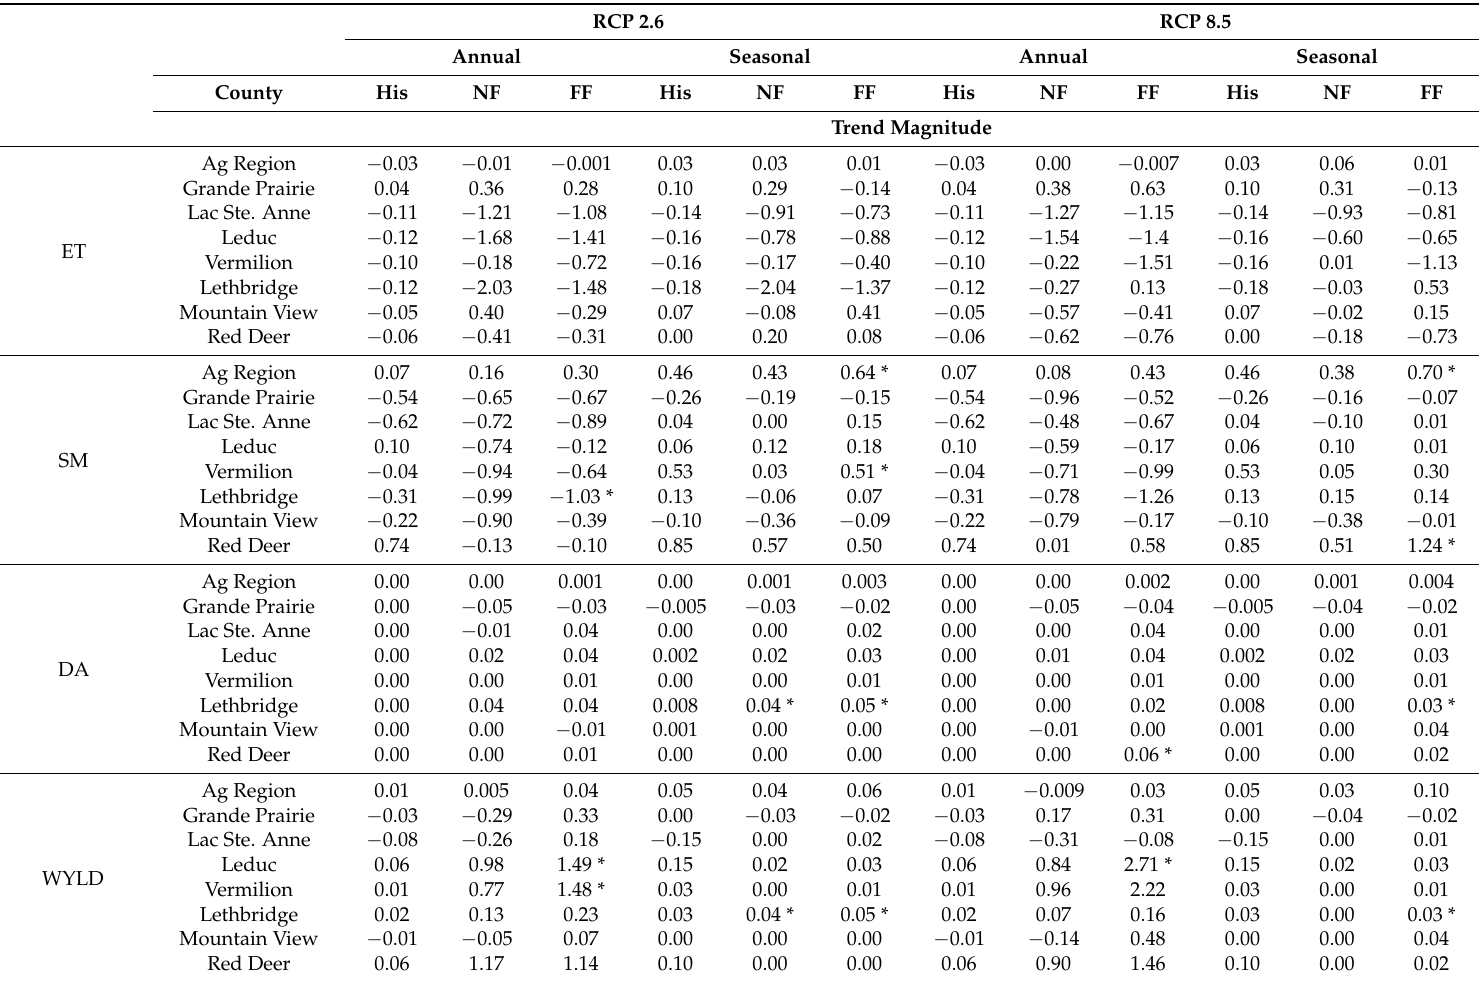
* indicates statistically significant at α = 0.05. ‘Ag Region’ indicates the entire study